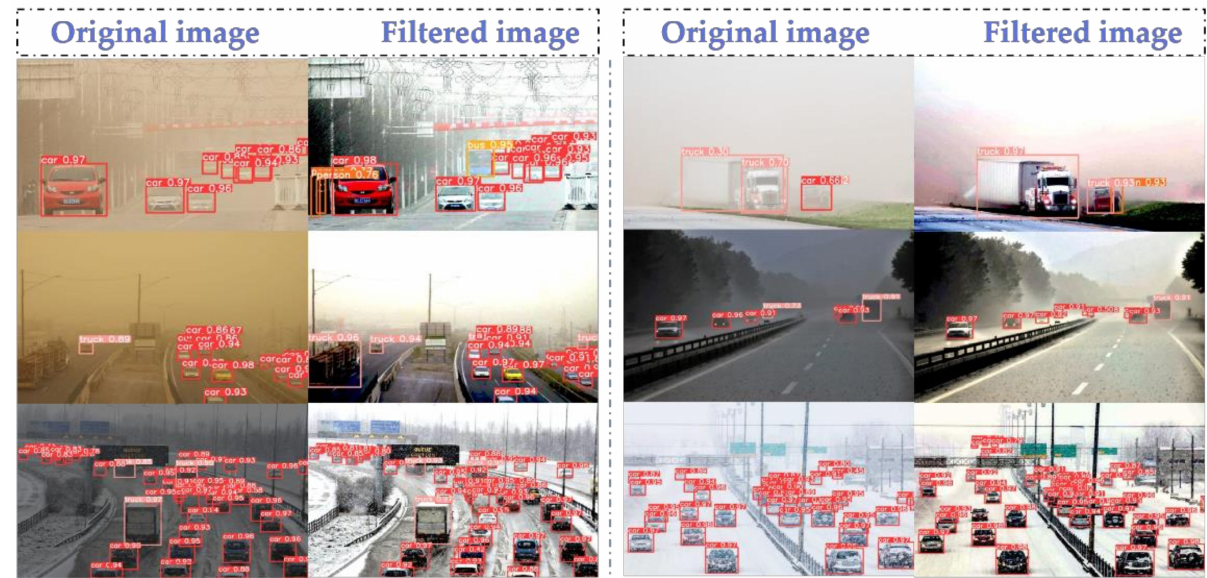
Figure 8. Graph of recognition results before and after image